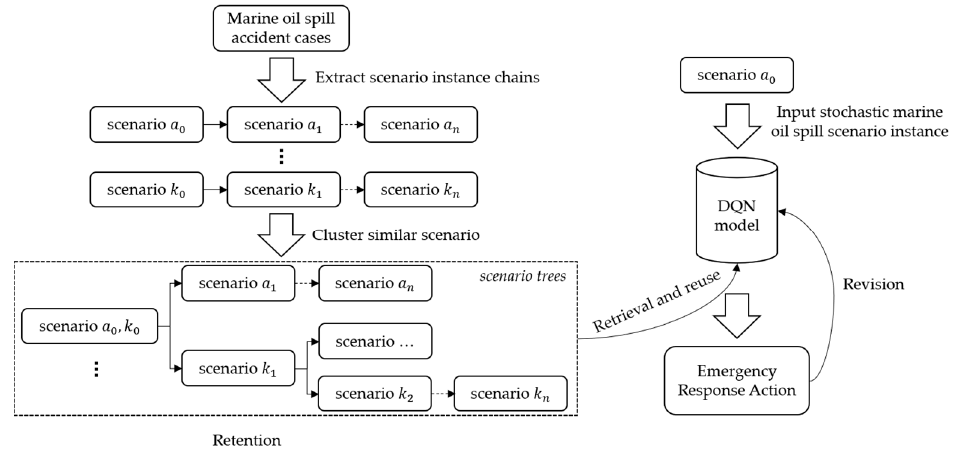
Figure 1. Four stages of the proposed framework. DQN = deep Q-network.